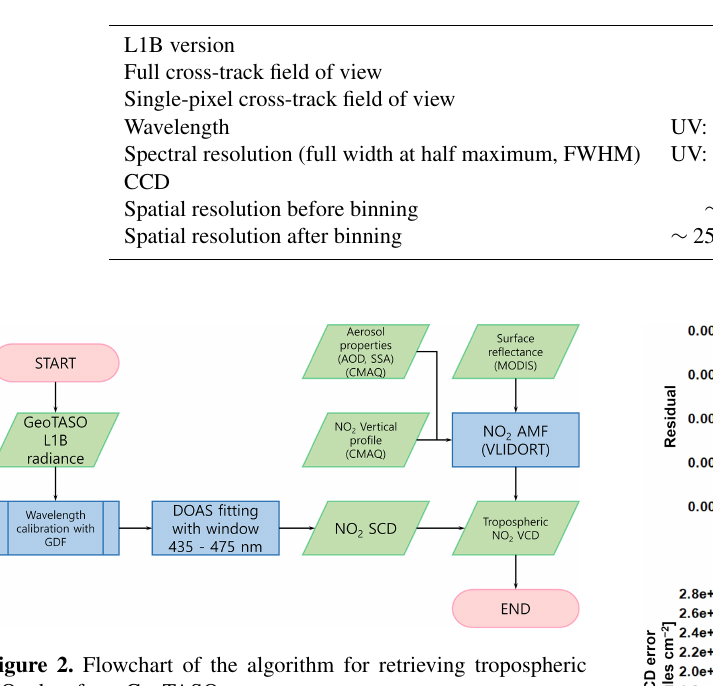
Table 2. Summary of the GeoTASO instrument and optical specification.